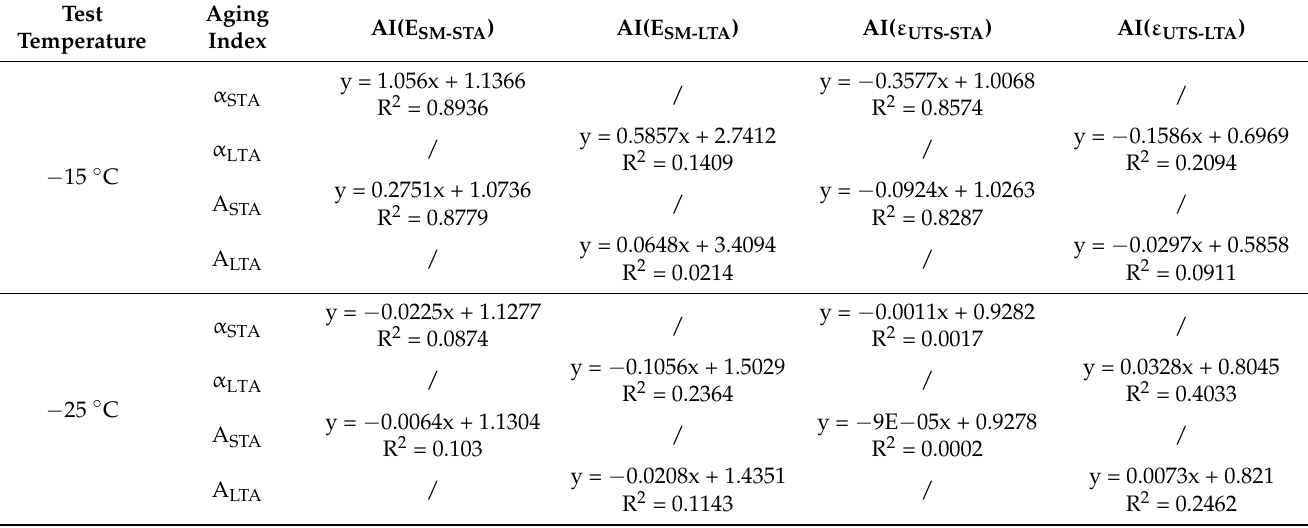
Table 15. Relationship between the rheological aging index and the thermal cracking